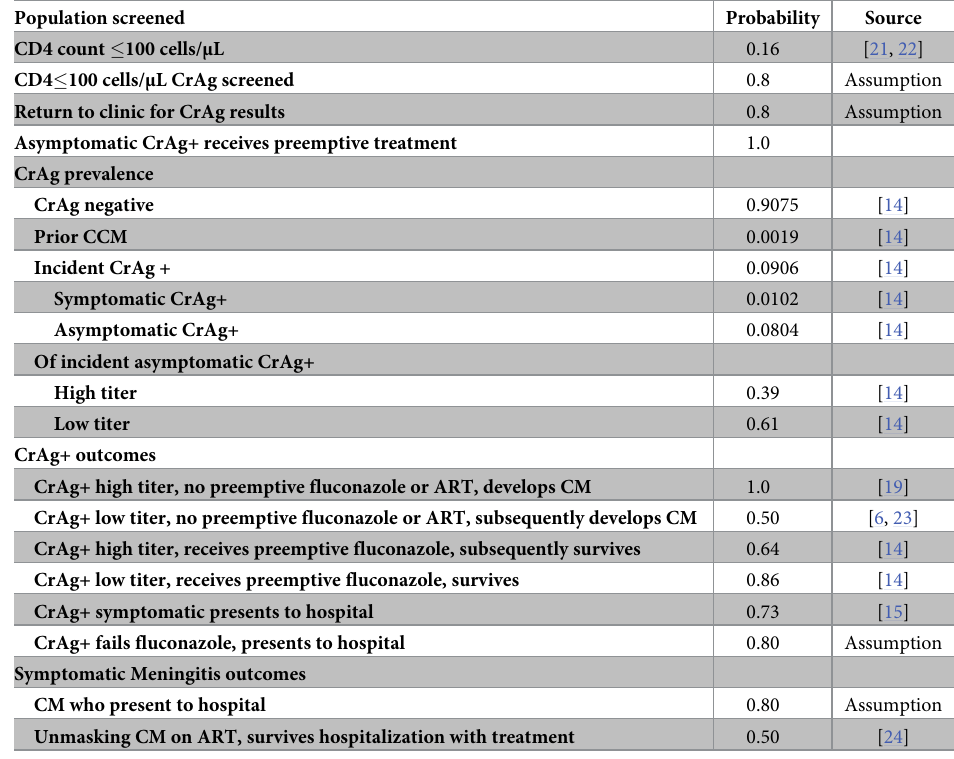
Table 4. Description of HIV-infected Population Screened in HIV test & treat model.